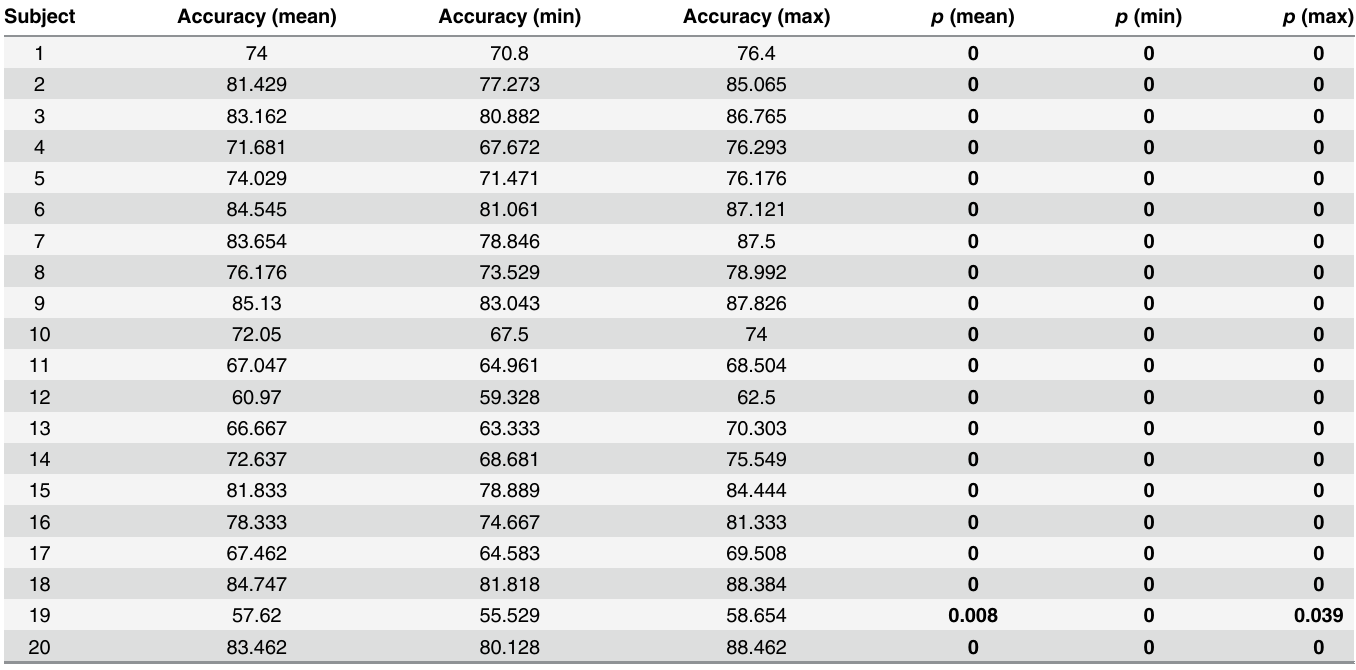
Table 4. Results Rotation Task